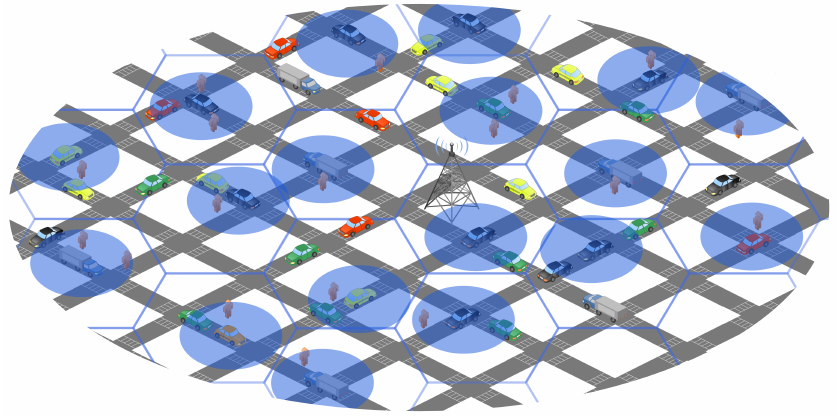
Figure 4. VILE perception